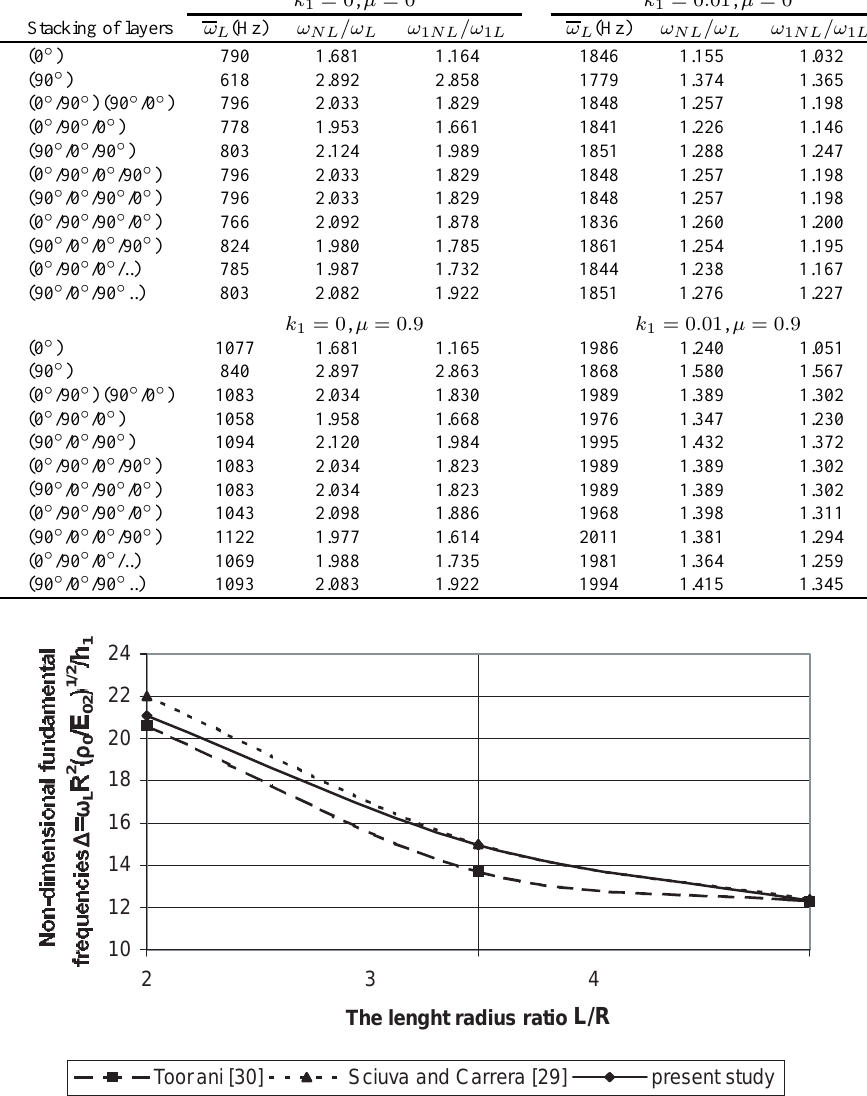
Fig. 4. Non-dimensional fundamental frequencies of simply supported cylindrical shell with symmetric cross-ply (0 ◦ /90 ◦ /90 ◦ /0 ◦ ). moduli in layers is taken into consideration in the form ϕ ( k ) ( z ) = exp( − 0 . 1 | z | ) and natural